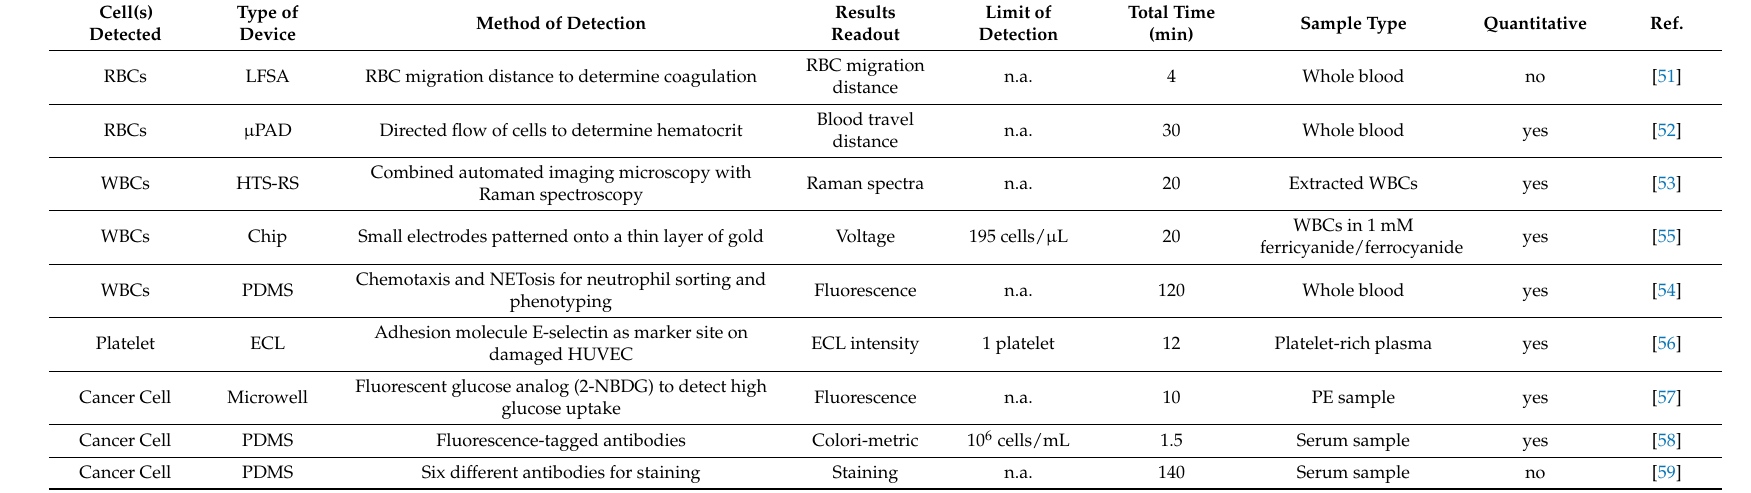
Table 3. Methods of detection and parameters for human cell detection